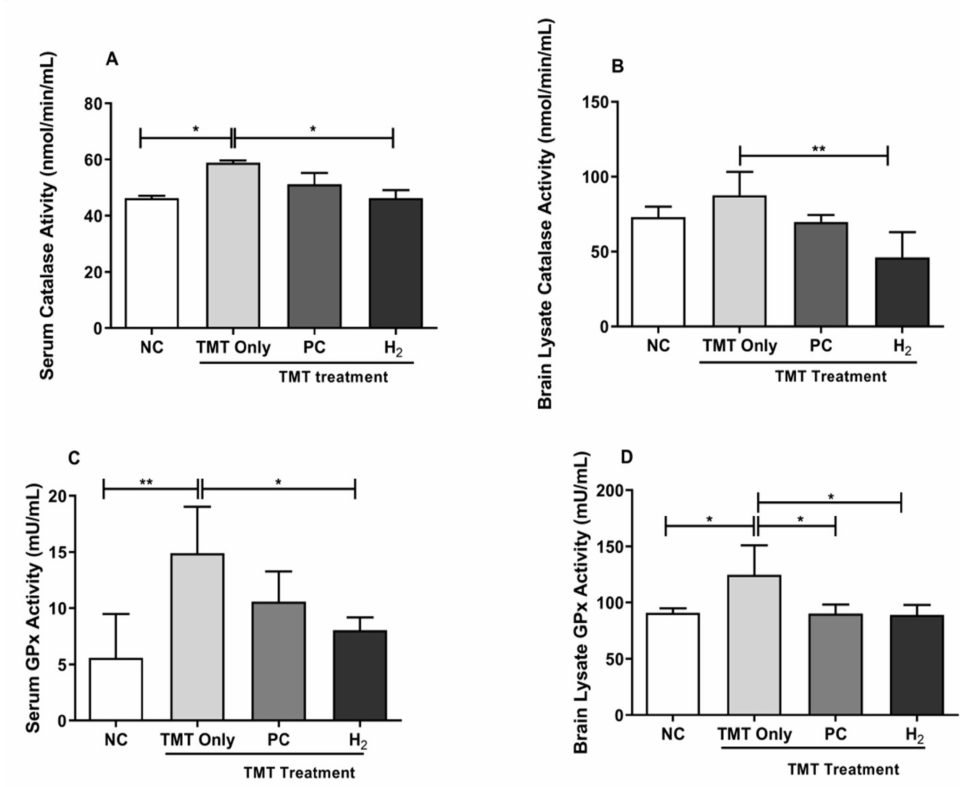
Figure 6. Effects of H 2 gas inhalation treatment on total intracellular catalase and GPx levels in TMT-induced C57BL/6 mice after four weeks. ( A ) Serum catalase level, ( B ) Brain lysate catalase level, ( C ) Serum GPx level, ( D ) Brain lysate GPx level. Data are shown as the mean ± SEM for n = 4 mice. Significant differences were analyzed with ANOVA and Tukey’s test. * p < 0.05, ** p <